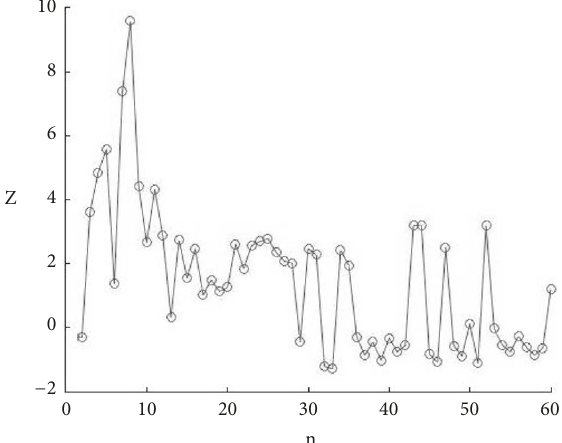
Figure 5: Graph Z ( n ) for William Blake’s poem “Spring.”